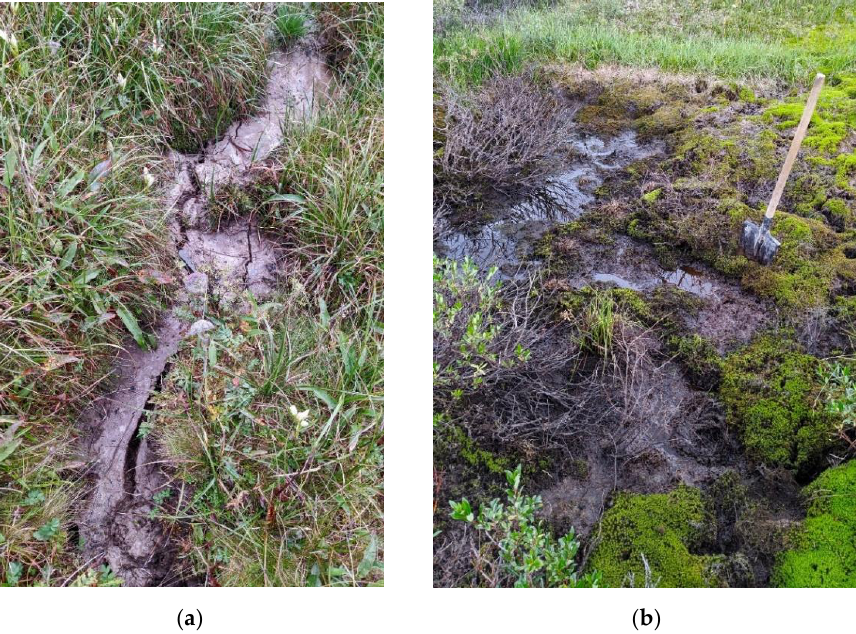
Figure 4. The surface of frozen mound with cracks ( a ), and micro-depressions ( b ). The palsa mire sites in Adyr-Khem river valley at Alash plateau; southern slope of the Western Sayan montane region, Republic of Tuva, Russia. The photos are by Kvasnikova dated: 30 July 2020, 15 July 2021. Geographical location of the